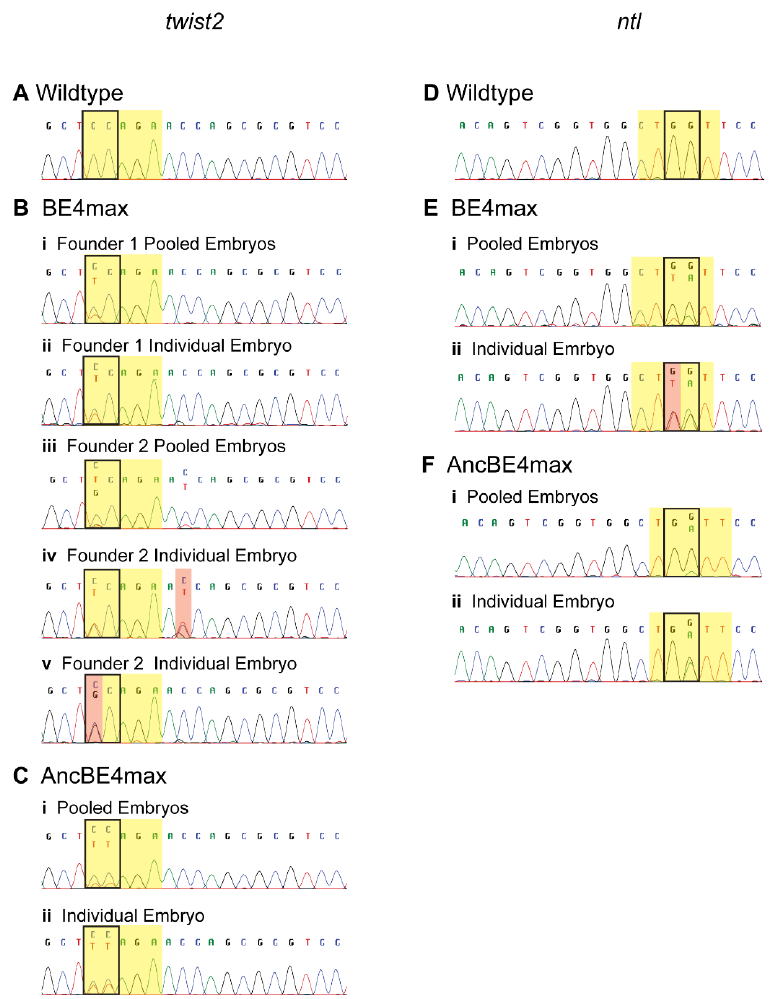
Figure 4. Germline base editing in pooled or individual embryos. Representative chromatograms of a wildtype embryo ( A , D ), pooled or individual F1 embryos at the twist2 ( B – C) and ntl ( E – F ) loci are shown with the target window highlighted in yellow and target nucleotides boxed. Correct base editing for twist2 (C → T) and ntl (G → A) is observed as a trace peak in pooled embryos or as heterozygous peaks in individual embryos ( ntl sgRNA is on the reverse strand and orientation shown is to depict the open reading frame). Incorrect bp changes and bystander edits are highlighted in red.